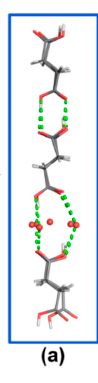
Figure 5. The evolution of the normalised unit-cell parameters as function of temperature (errors at 3 σ level) taken from the structures in Supplementary Table S1, see Supplementary Information for details.